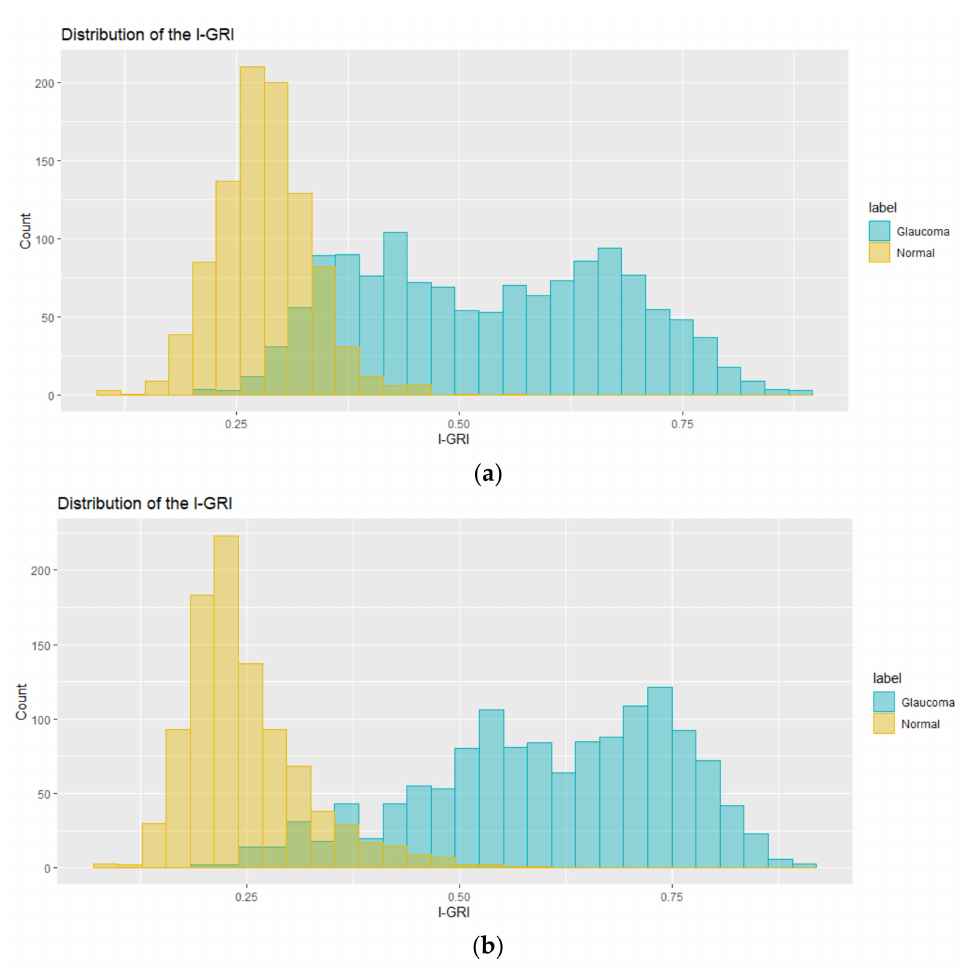
Figure 8. Effect of the NNI on the I-GRI measure. ( a ) Before applying the NNI; ( b ) after applying the